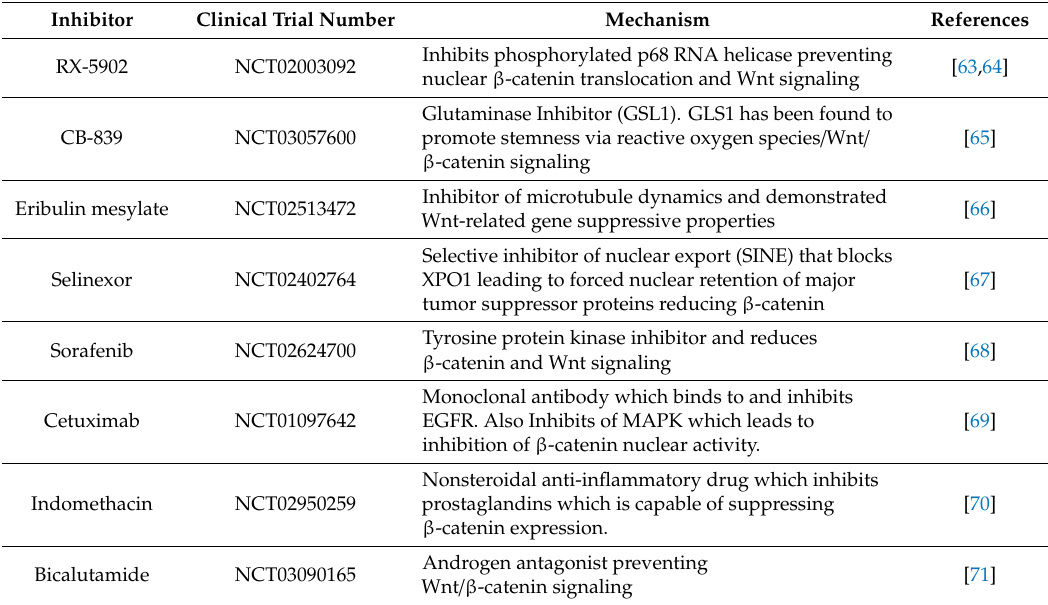
Table 1. Potential Wnt Inhibitors Tested in TNBC Clinical